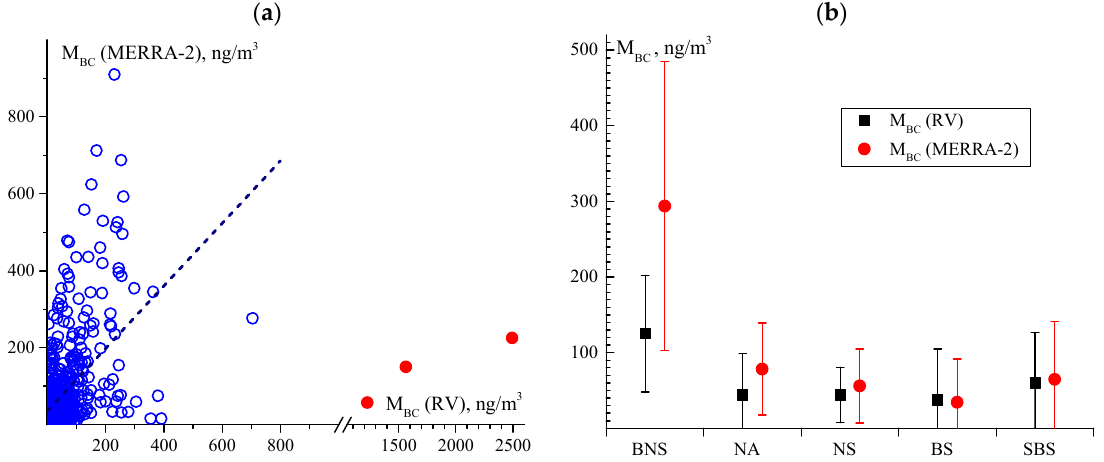
Figure 11. ( a ) Regression relationship of M BC concentrations according to modeling (MERRA-2) and ship measurements (RV); ( b ) comparison of black carbon concentrations in five areas (concentration M BC (RV) in the BNS area is given without taking into account three outliers).